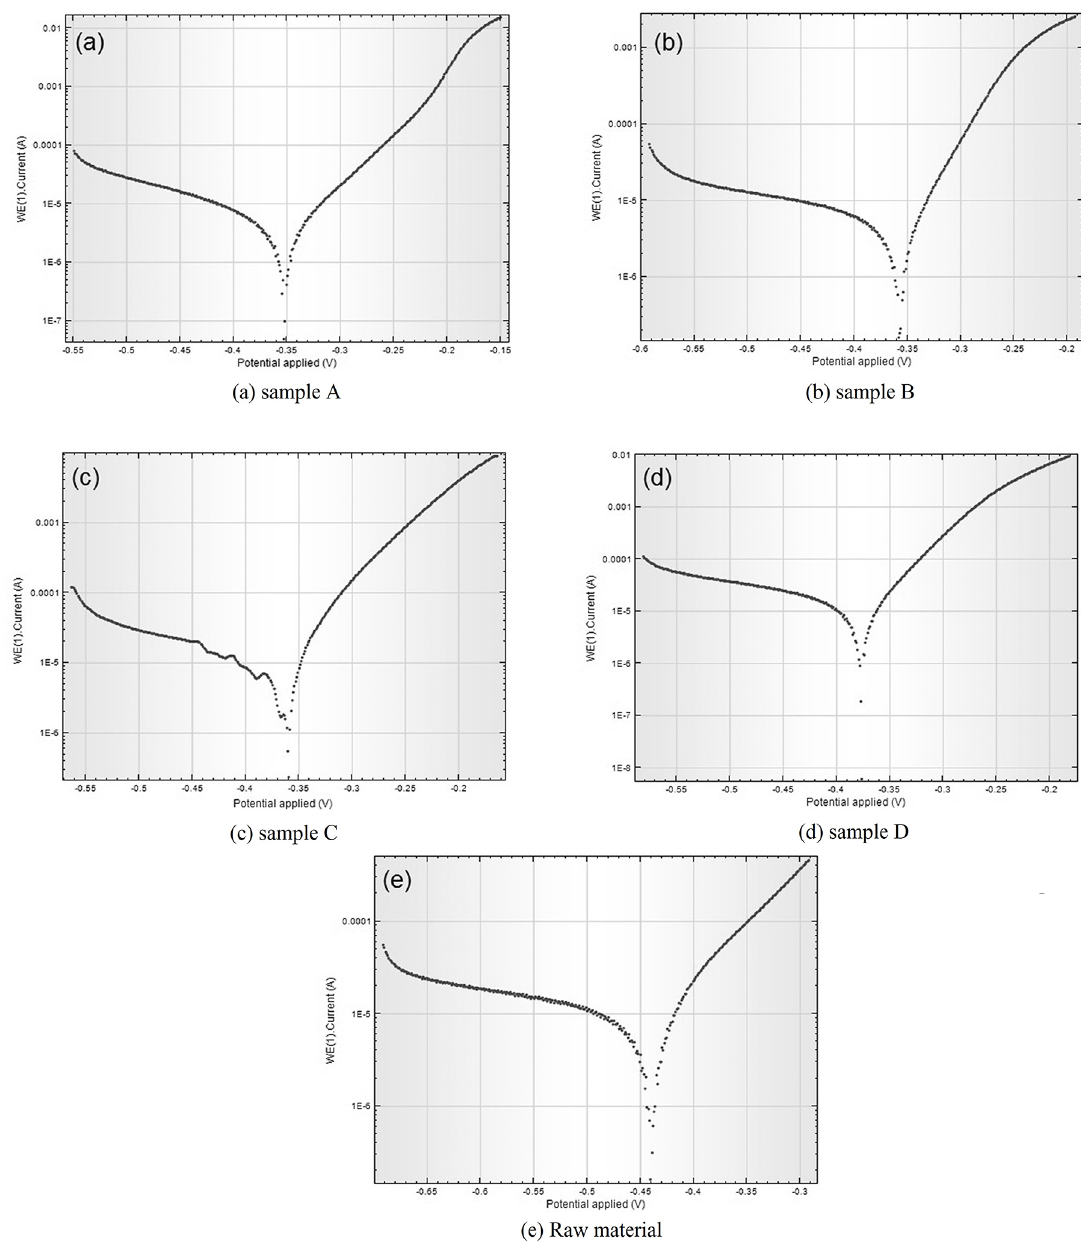
Figure 8. Potentiodynamic polarization curves.